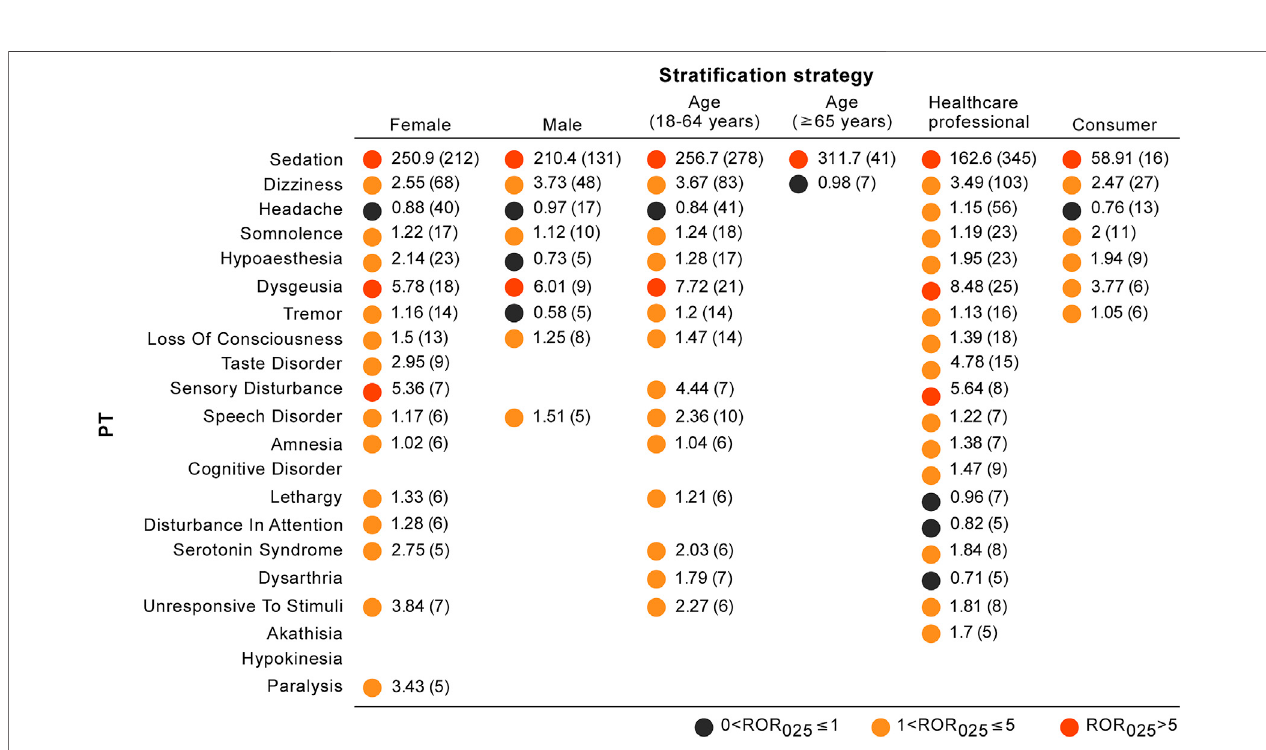
Frontiers in Pharmacology |